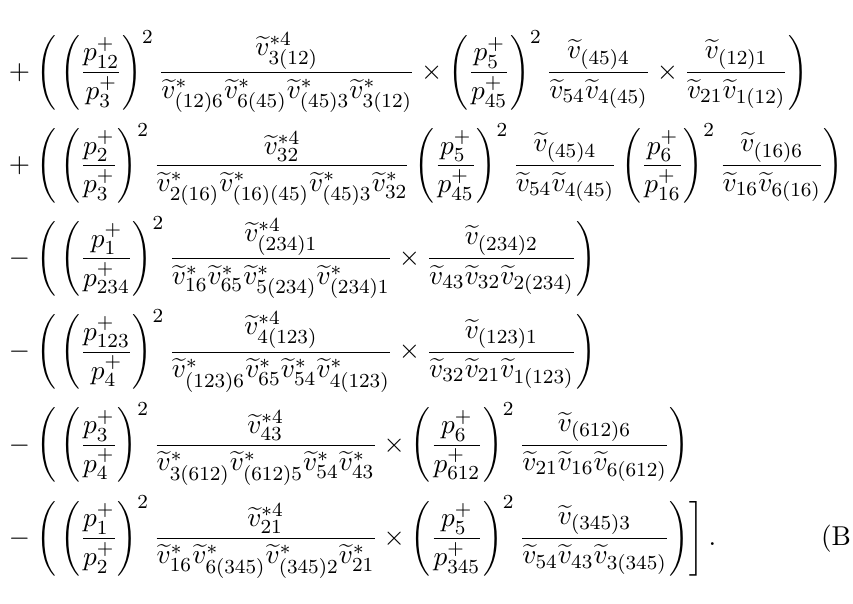
Figure 10 . The contributions to the color-ordered 6 point MHV vertex, with helicity ( −−−− ++)